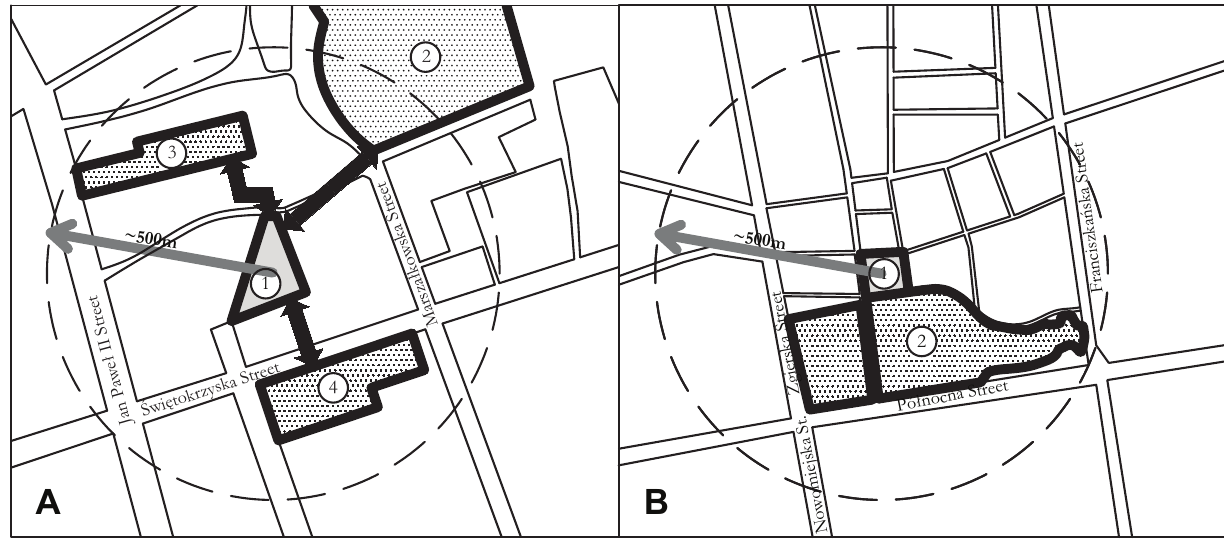
Figure 1. A) Location of city parks in the vicinity of Grzybowski Square (within 0.5 km): 1. Grzybowski Square, 2. Ogród Saski (The Saxon Garden), 3. Park Mirowski (Mirowski Park), 4. Park Świętokrzyski (Świętokrzyski Park); B) Location of city parks in the vicinity of Old Market Square (within 0.5 km): 1. Old Market Square, 2. Park Staromiejski (Staromiejski